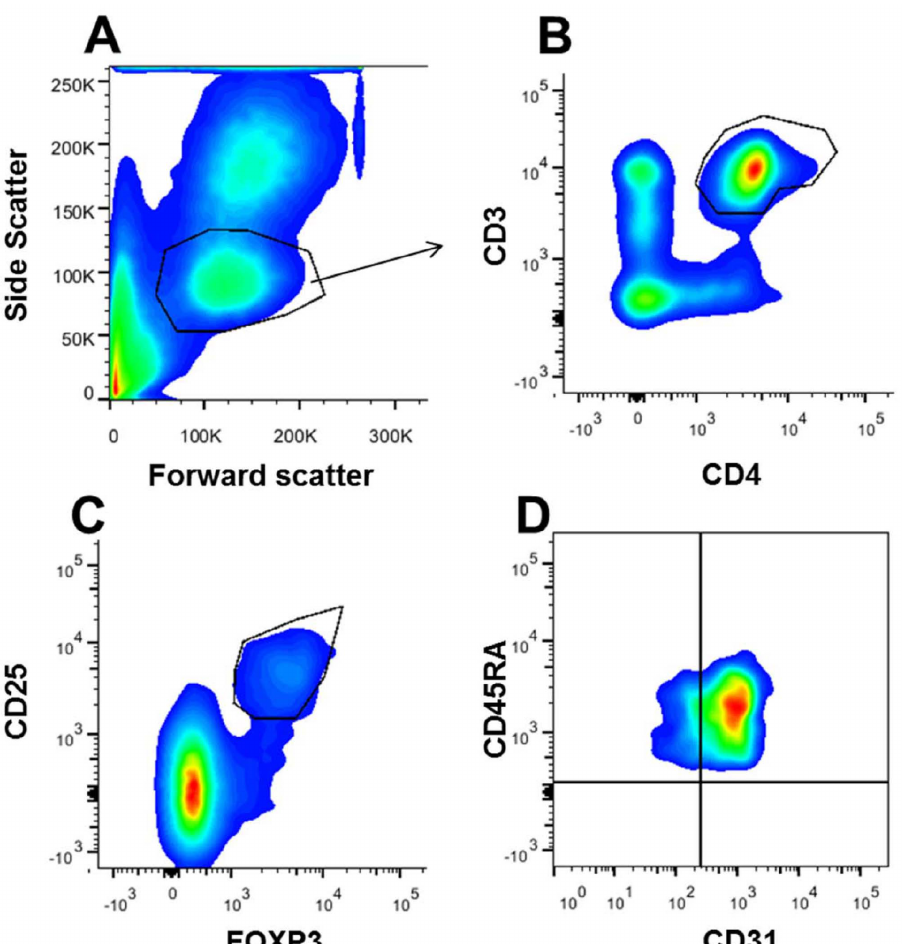
Figure 1. Cord blood flow cytometry analysis of regulatory T cells. Cord blood mononuclear cells were surface stained with fluorochrome labeled monoclonal antibodies followed by intranuclear staining for FOXP3, fixation and flow cytometric analysis. ( A ) Box-plot with lymphocytes gated based on size (FSC) and granularity (SSC). ( B ) Neonatal CD4 + T cells are selected based on CD3 and CD4 co-expression (box-plot). ( C ) Neonatal regulatory T cells (CD3 + CD4 + ) are selected based on CD25 and FOXP3 co-expression (box-plot). ( D ) Regulatory T cells (CD3 + CD4 + CD25 + FOXP3 + ) subpopulations selected by the expression of CD45RA and CD31 (CD45RA + CD31 + recent thymic emigrant, CD45RA + CD31 2 peripherally induced naı¨ve regulatory T cell)